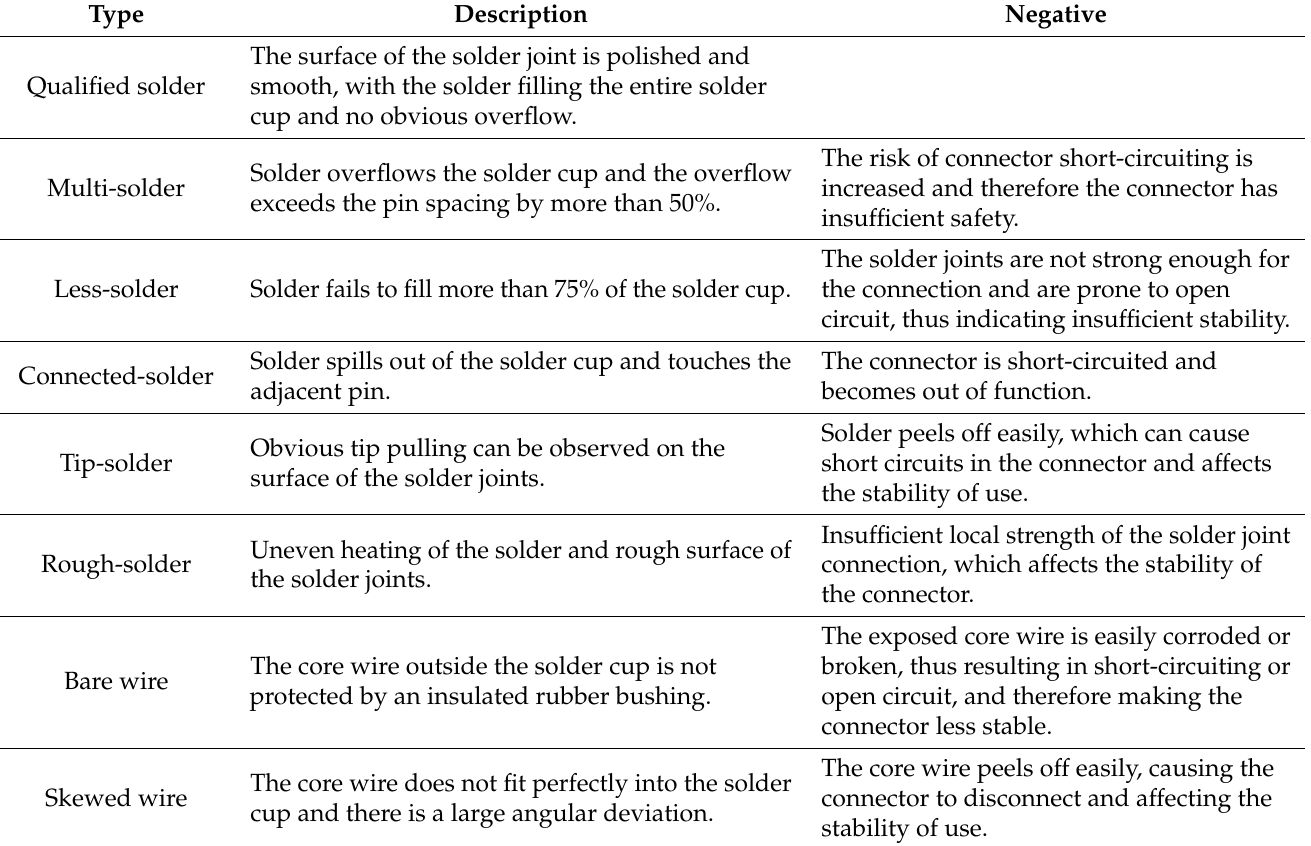
Table 1. Detailed description of solder joints to be